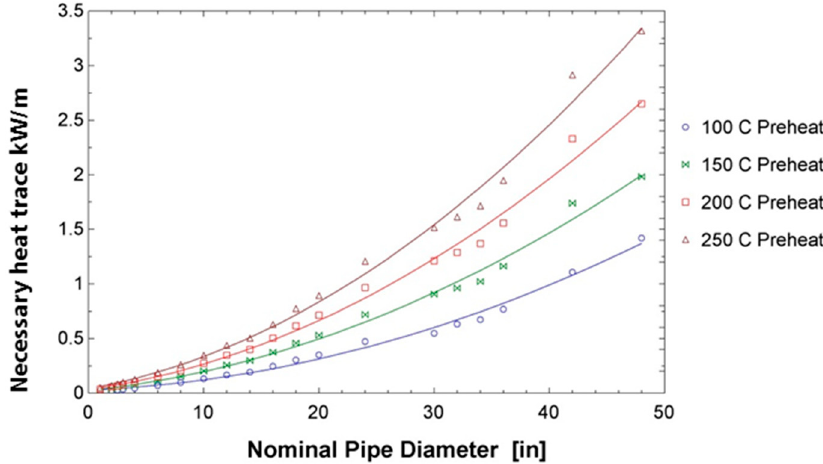
Figure 9. Required heat trace systems for different levels of preheating for the full range of schedule 40 piping, with a wind speed of 5 m/s and an ambient temperature of 15 °C.